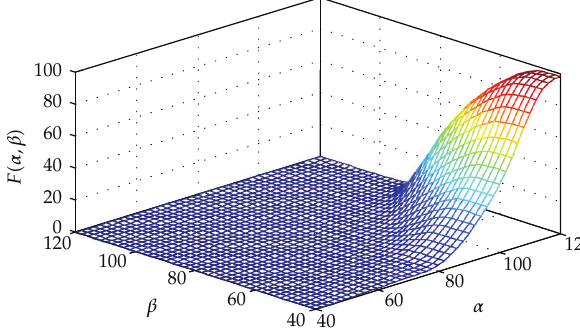
Figure 15: Surface F (cid:2) α,β (cid:3) identified by ANN using training data